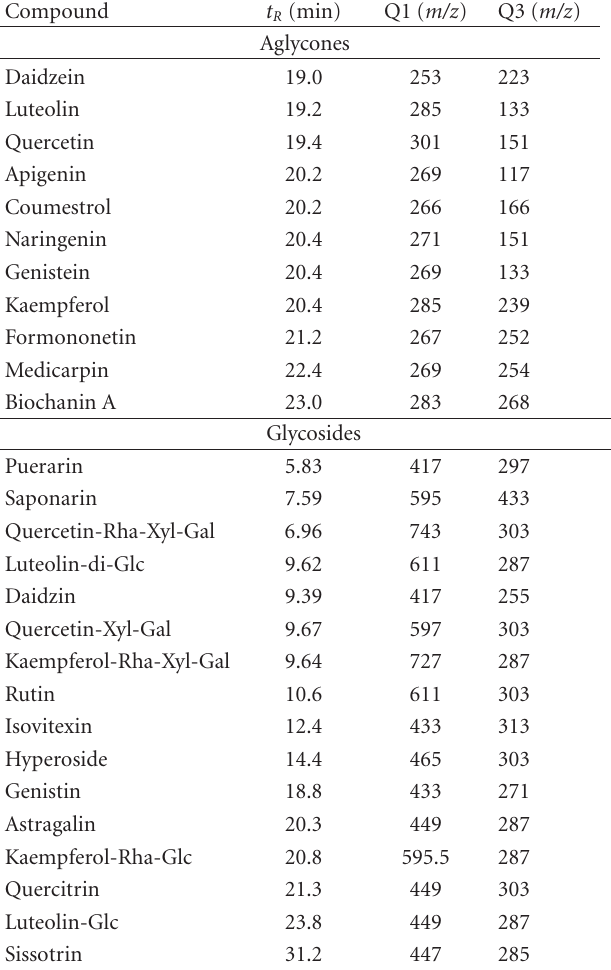
Table 3: Mass-to-charge ratio ( m/z ) used in selected ion monitor- ing and retention